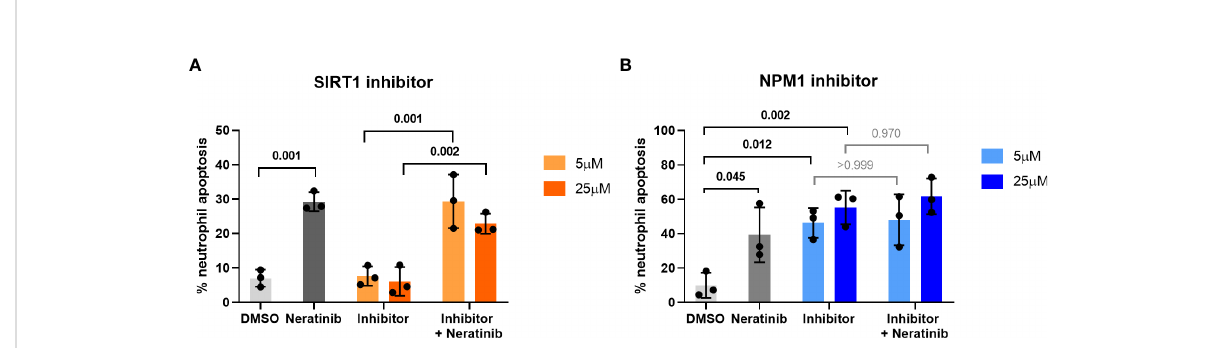
FIGURE 3 Pharmacological inhibition of candidates from the phosphoproteomic analysis reveals NPM1 as potentially being downstream of neratinib- induced neutrophil apoptosis. Human neutrophils were incubated with inhibitors of SIRT1 or NPM1, alone or in combination with 25 m M of neratinib, for 6 h, after which the levels of apoptosis were assessed by morphology. In both experiments, neratinib alone induced neutrophil apoptosis in comparison to the DMSO control, as expected. The inhibitor of SIRT1 (EX527) did not induce human neutrophil apoptosis (A) . The inhibitor of NPM1 (NSC348884) did induce human neutrophil apoptosis (B) , and no additional apoptosis was observed when this inhibitor was used in combination with neratinib. Each data point shows data from one healthy donor ( n = 3); bars represent mean ± standard